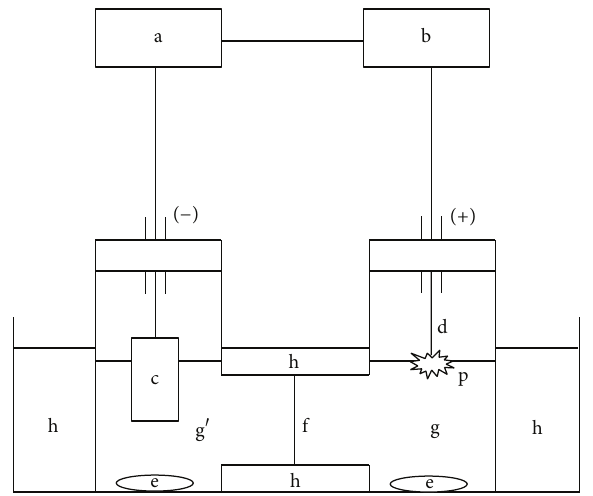
Figure 1: Apparatus for CGDE. a: digital coulomb meter; b: Dc power supply; c: cathode; d: anode; e: Teflon-coated magnet bar; f: Nafion membrane N117; g: electrolytic solution; g 󸀠 : phosphate buffer solution; h: ice-water bath; p: plasma.